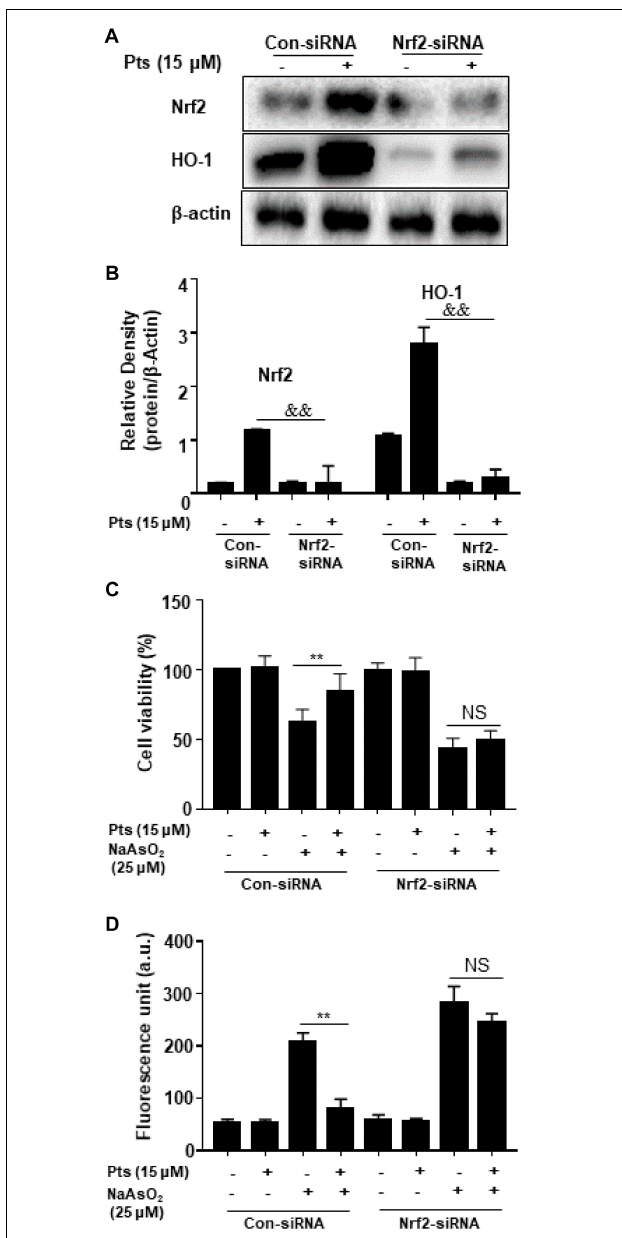
FIGURE 7 | Effects of Nrf2-siRNA transfection on Pts-induced Nrf2 and HO-1 protein expression and protection on NaAsO 2 -induced cytotoxicity. (A,B) Nrf2 mediates Pts-induced HO-1 protein expression. Nrf2-siRNA or Nrf2-negative control siRNA were transfected into cells for 24 h and then were treated with Pts (15 µ M) for 24 h. (C) Nrf2 mediates Pts-induced protection against NaAsO 2 -induced cytotoxicity. Cells were transfected with either control-siRNA or Nrf2-siRNA for 24 h, and then were left untreated or co-treated NaAsO 2 (25 µ M) with or without Pts (15 µ M) for 24 h. Cell viability was measured using the MTT assay. (D) Nrf2 mediates Pts-induced protection against NaAsO 2 -induced oxidative stress in HaCaT cells. Cells were transfected with either control-siRNA or Nrf2-siRNA for 24 h, and then were left untreated or co-treated NaAsO 2 (25 µ M) with or without Pts (15 µ M) for 24 h. ROS generation was measured by the DCFH-DA method using a multi-detection reader. The results are expressed as the means ± S.E.M. of three independent experiments. ∗∗ P ≤ 0.01 versus the NaAsO 2